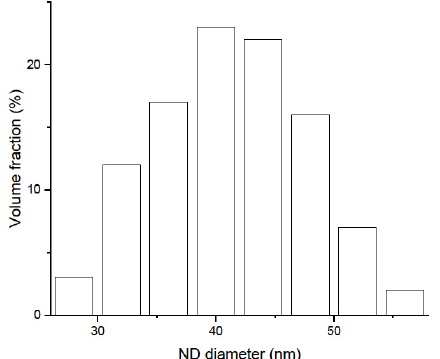
Figure 1. Diameter distribution of ND in the SCD powder measured by Ferran using a Beckman Coulter laser diffraction particle size analyzer. Note that the sensitivity of the method sharply decreases for small NDs (below ~30 nm), and the method should not be used in this